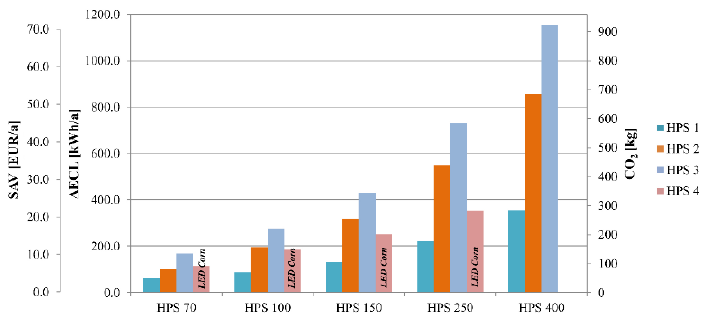
Figure 4. Annual energy savings, financial savings and reductions in CO 2 emissions for different energy efficiency improvement scenarios—HPS lamps. Table 7. The cost of a single lamp on the local market.